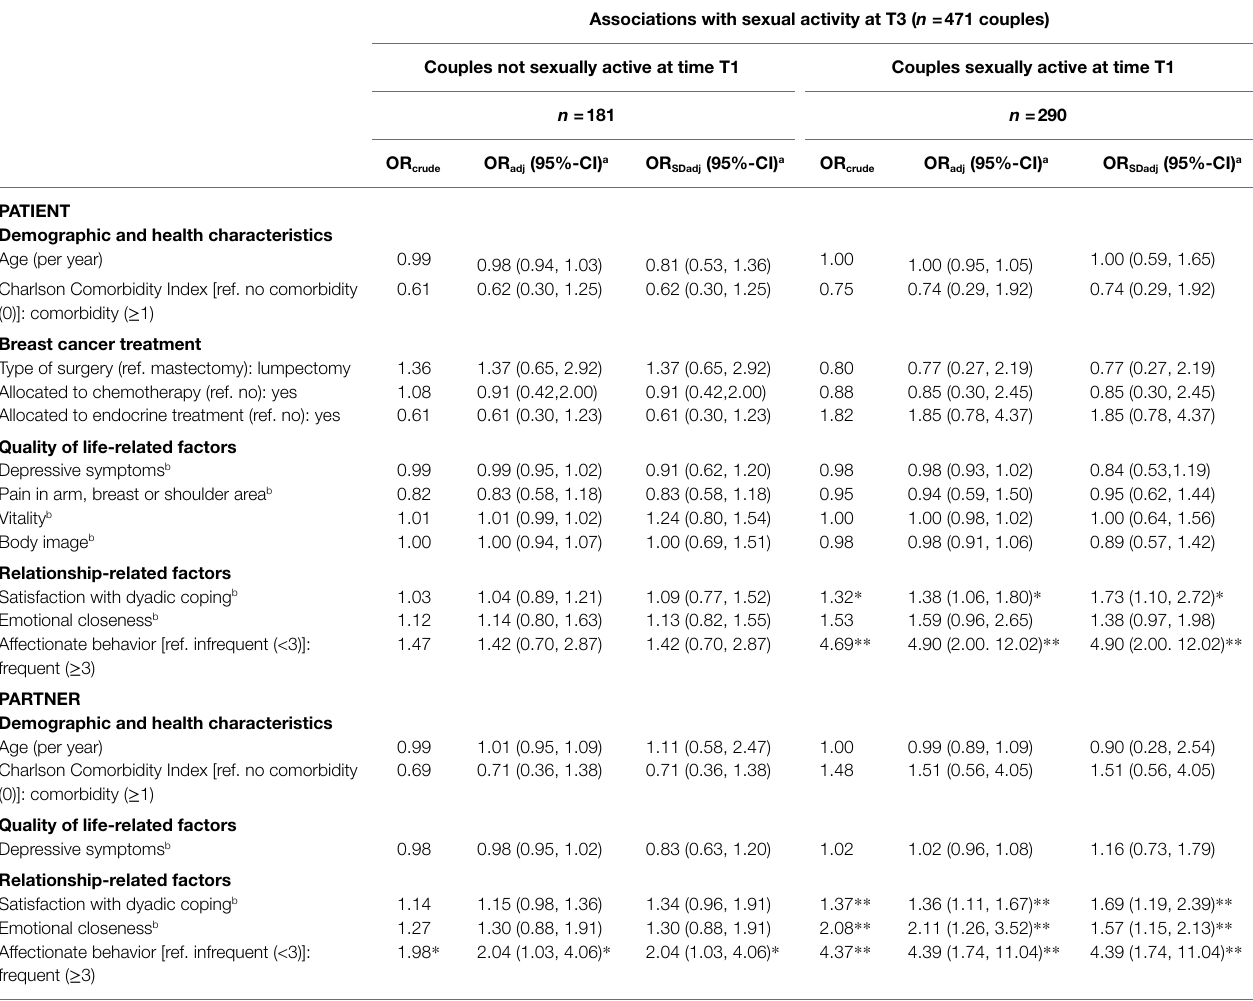
TABLE 5 | Associations between patient and partner characteristics and sexual activity at time T3, stratified on baseline sexual activity. Associations with sexual activity at T3 ( n = 471